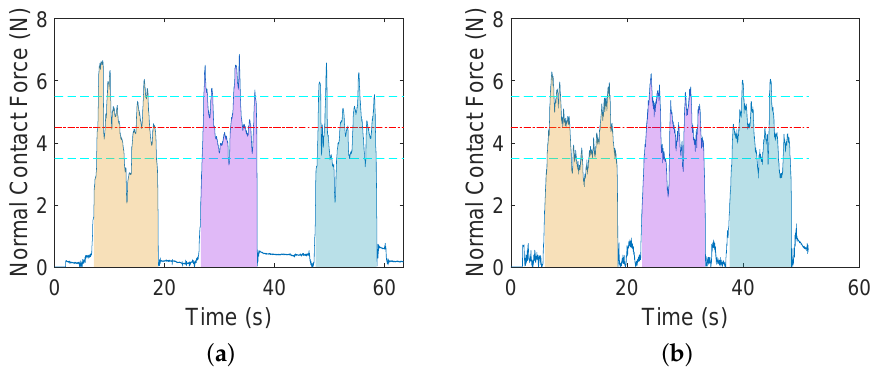
Figure 4. Sample data for US scanning on horizontal tissue surface with different feedback are provided in two modes in Experiment 1. AF means audio feedback; HF means haptic feedback. Two horizontal dashed cyan lines define the tolerance area for the desired force. ( a ) AF + HF ( p HRI mode). ( b ) AF ( tele HRI